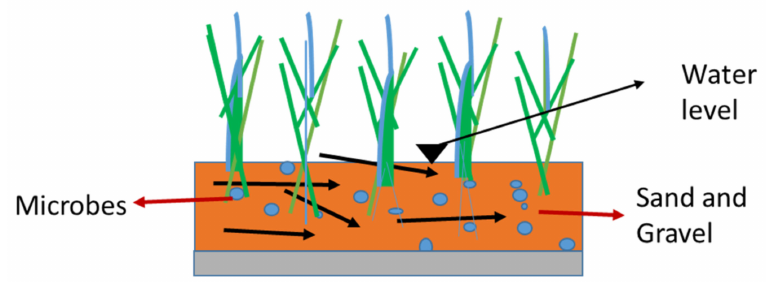
Figure 2. Schematic layout of horizontal subsurface